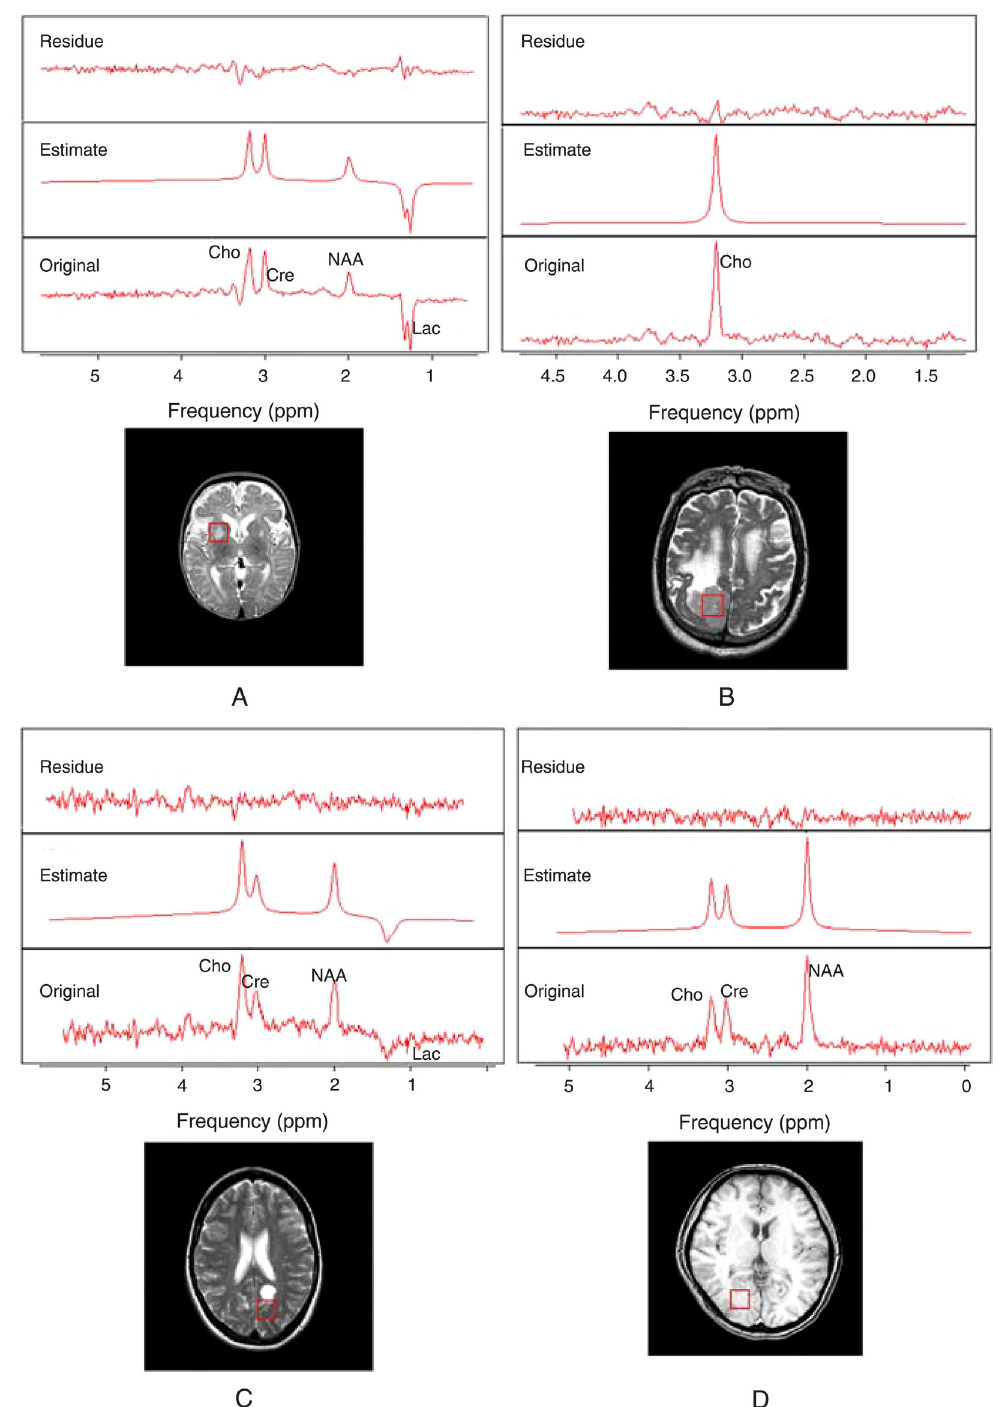
Figure 1. Typical spectra from the tumor and control groups. Typical 1 H-MRS and MRI of patients with A , high-grade neuroglial tumors (group 1); B , meningioma (non-neuroglial tumors, group 2); C , pilocytic astrocytoma (group 3), and D , of a control subject (group 4). 1 H-MRS = proton magnetic resonance spectroscopy; MRI = magnetic resonance imaging ; Cho = choline group; Cre = creatine and phosphocreatine; Lac = lactate; NAA =